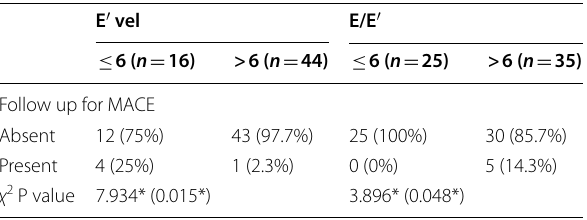
χ 2 , Chi square test; p , p value for comparing between the studied groups *Statistically significant at p ≤